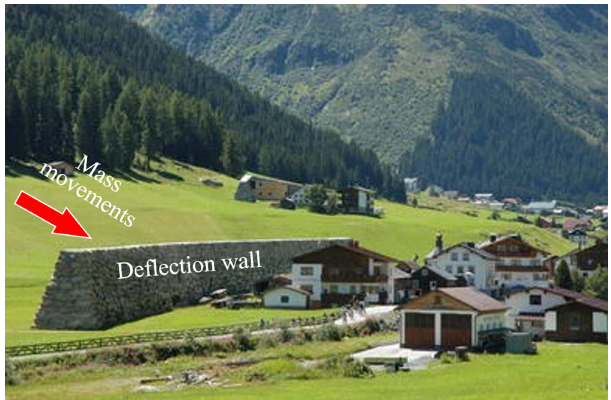
Figure 9. A deflection wall used to protect an entire building ensemble from the impact of medium-magnitude events (Galtur Tschafein, Austria) (Holub et al.,